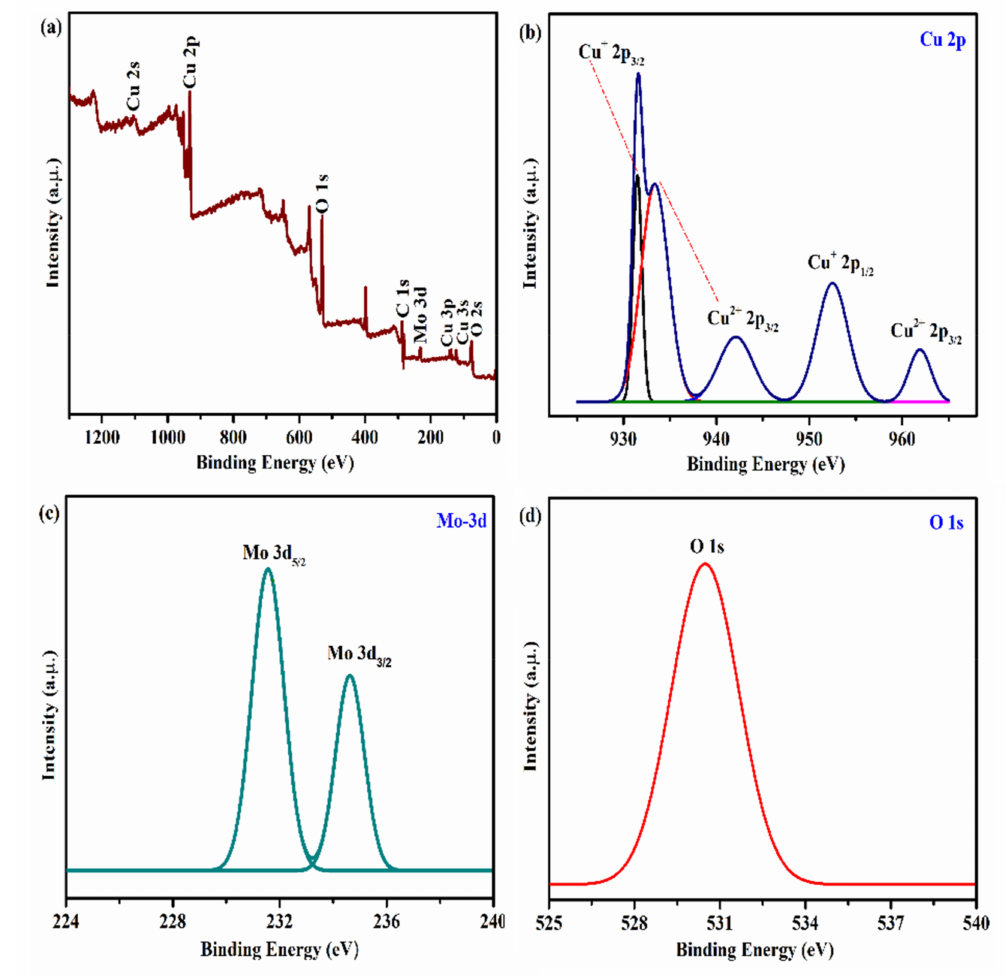
Figure 4. ( a ) XPS survey spectrum for MoCu-4, high resolution XPS spectra for ( b ) Cu 2p, ( c ) Mo-3d and ( d ) O